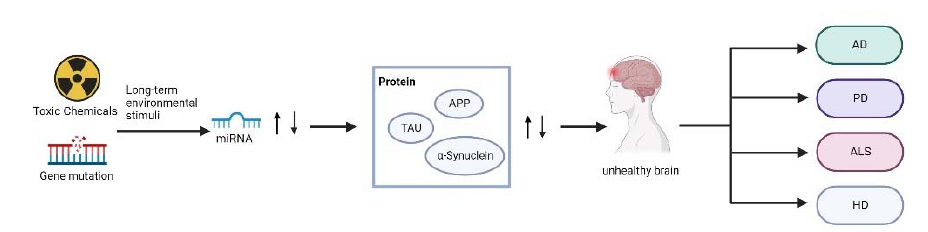
Figure 3. Schematic diagram of the role of miRNA in neurodegenerative diseases. Table 1. MiRNAs involved in pathological changes of neurodegenerative diseases.